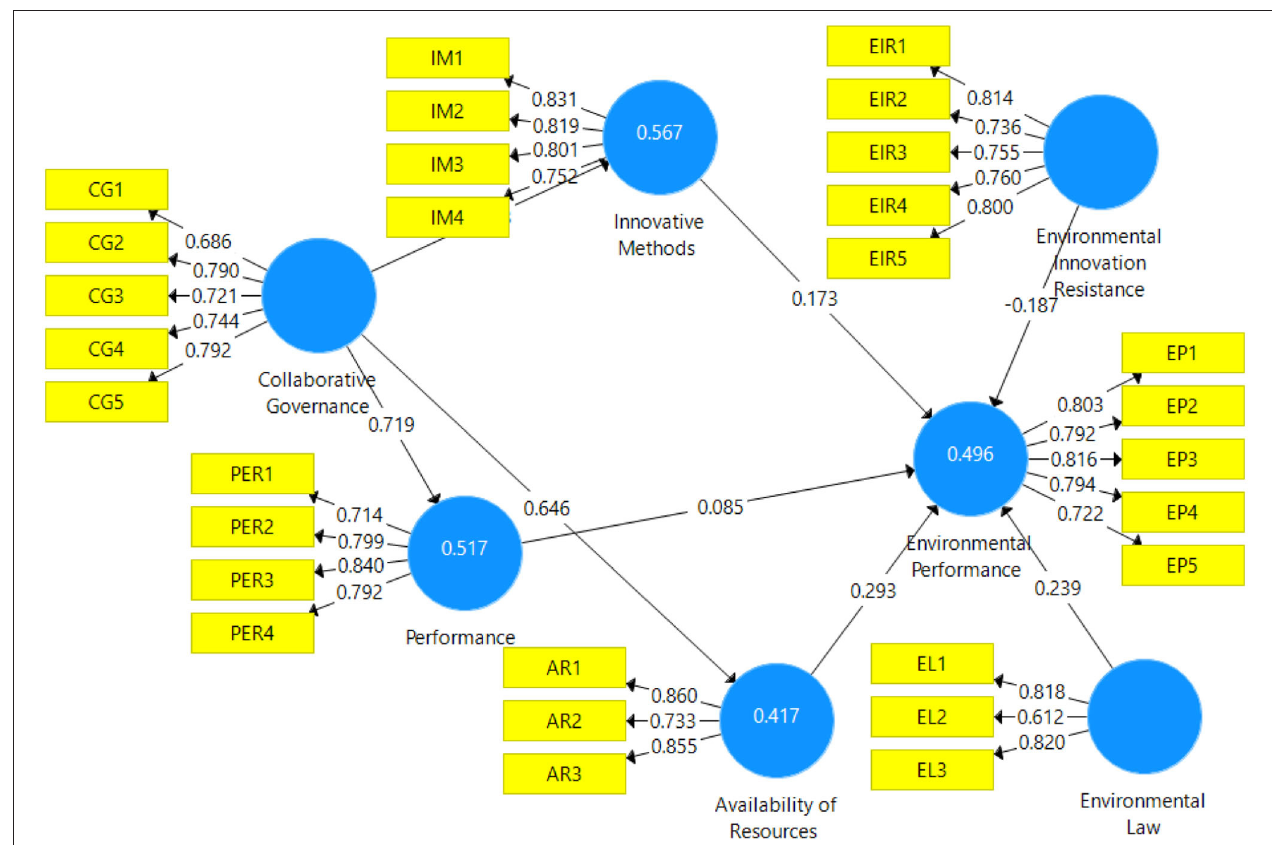
FIGURE 2 | Measurement Model. CG, Collaborative Governance; IM, Innovative Methods; PER, Performance; AR, Availability of Resources; EIR, Environmental Innovation Resistance; EL, Environmental Law; EP, Environmental